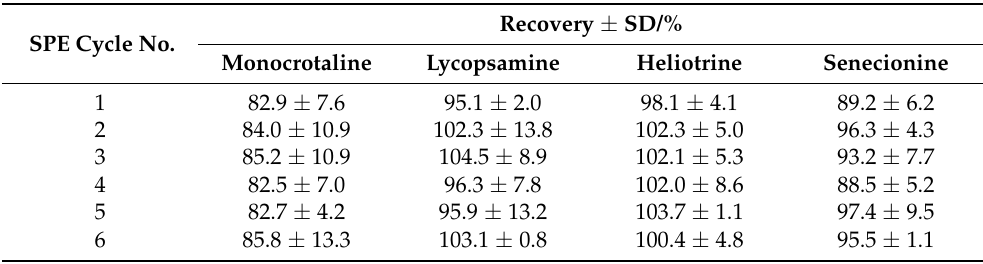
Table 6. Averaged recoveries over six cycles of solid phase extraction using the same HNT-MPTMS- SO 3 H solid